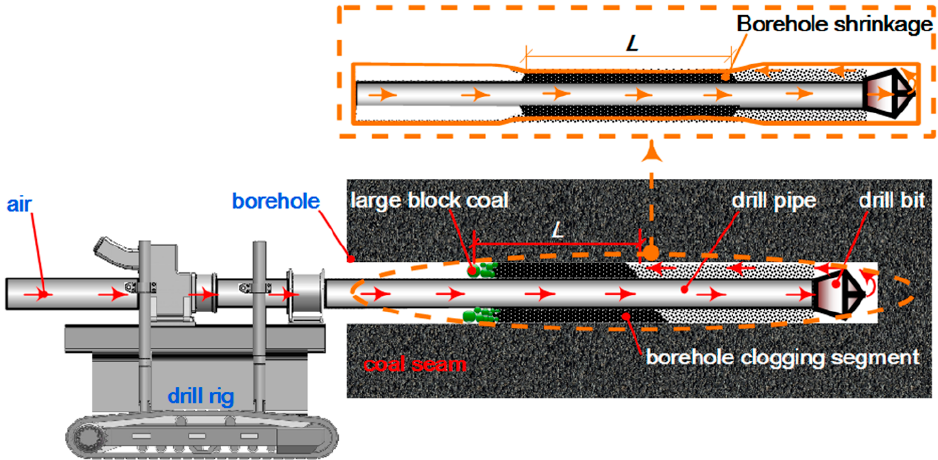
Figure 2. A clogging segment formed in a normal borehole.